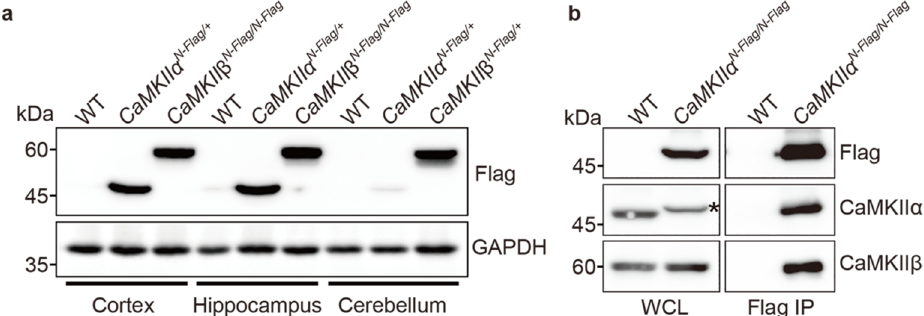
Figure 3. Expression of Flag-CaMKIIα and β and association between Flag-CaMKIIα and endoge- nous CaMKIIβ. ( a ) Immunoblotting of cortical, hippocampal, and cerebellar samples in CaMKIIα N-Flag/+ heterozygous and CaMKIIβ N-Flag/N-Flag homozygous knock-in mice using anti-Flag antibody. GAPDH was used as internal control. ( b ) Immunoblotting using anti-Flag, CaMKIIα, and CaMKIIβ specific antibodies, after immunoprecipitation of cortex sample in CaMKIIα mouse using flag antibody (Flag IP). WCL, whole cell lysate. Asterisk shows shifted band of Flag-CaMKIIα protein, com- pared to that of endogenous CaMKIIα protein.